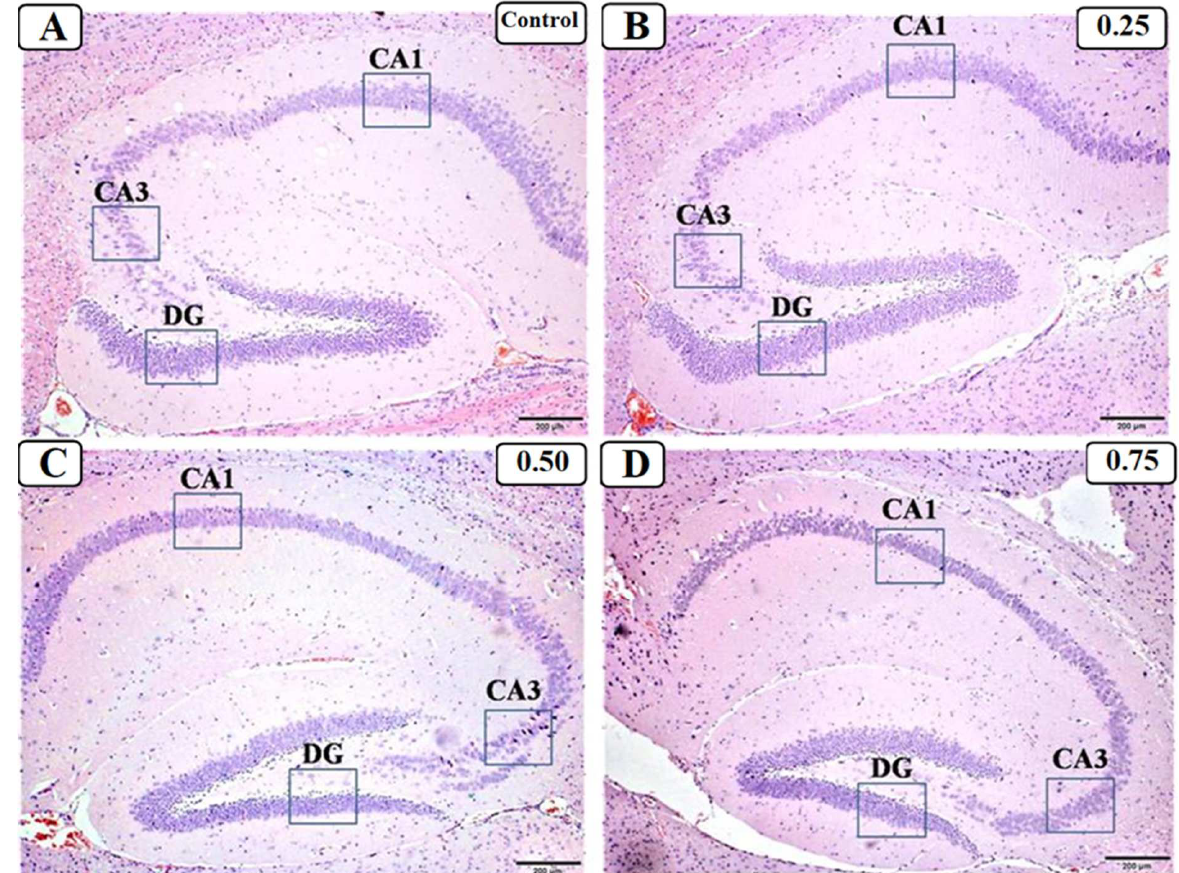
Figure 5. Representative photomicrographs of a sagittal section of the hippocampus in ( A ) control, ( B ) 0.25 LPS, ( C ) 0.50 LPS, and ( D ) 0.75 LPS groups. It shows different parts of the hippocampal structure, including the cornu ammonis (CA) and dentate gyrus (DG). The CA is subdivided into